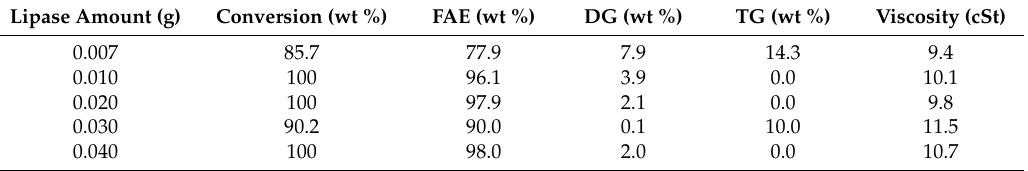
Table 1. Influence of the amount of Lipopan BG (Novozymes AS, Denmark) in the ethanolysis reaction performance, developed under standard conditions; fatty acid esters